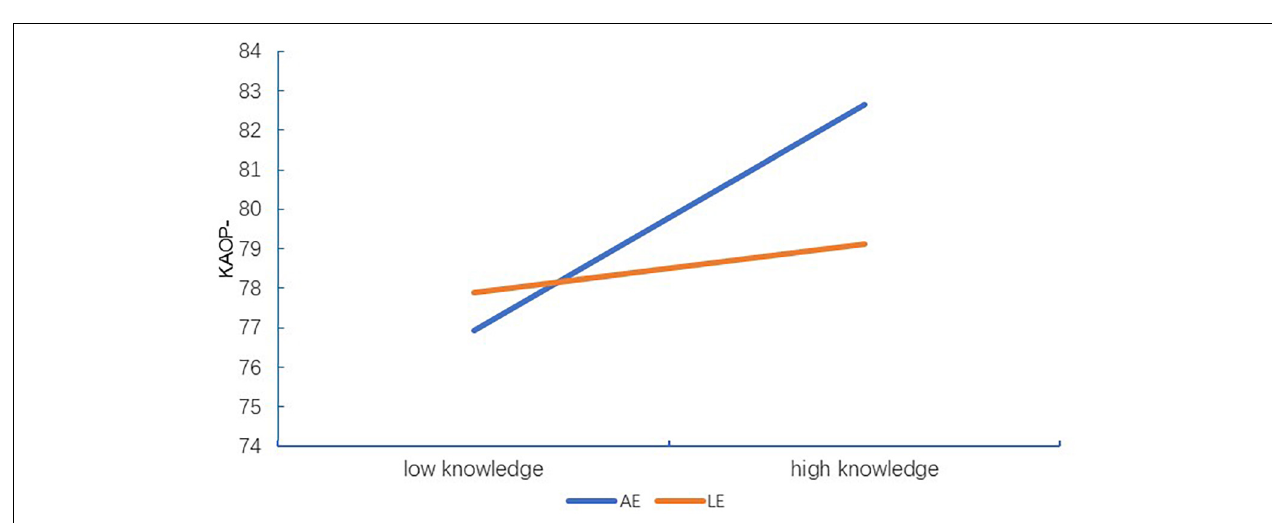
FIGURE 2 | Interaction effect of empathy profile and knowledge of aging on attitudes toward older adults among nursing students. KAOP, total mean scores of Kogan’s Attitude Toward Older People Scale; AE, average empathy subgroup; LE, low empathy subgroup.